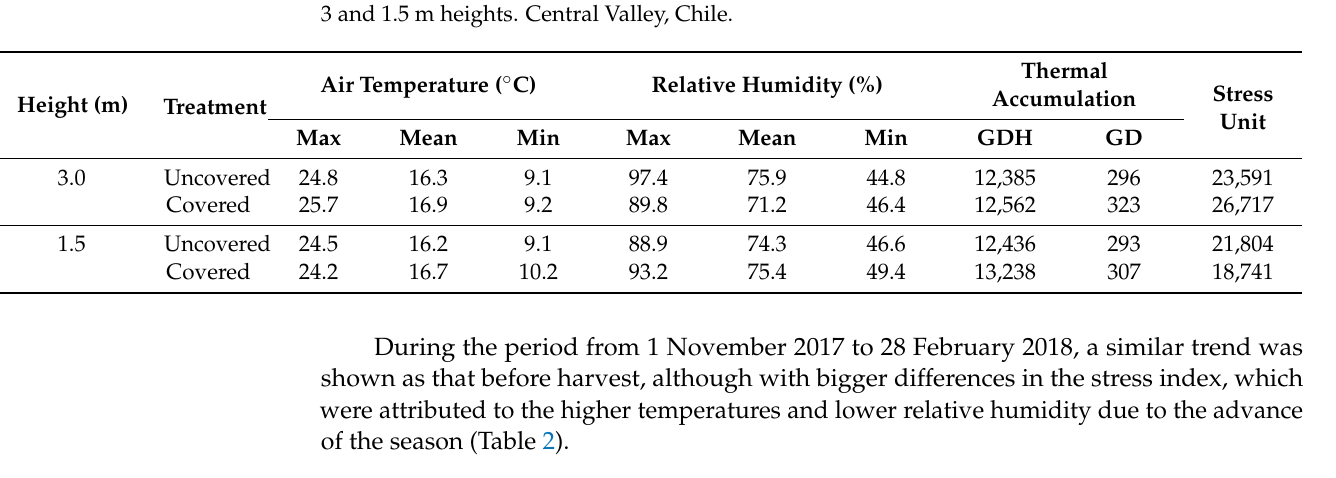
Table 2. Air temperature, relative humidity, thermal accumulation and stress index between 1 November 2017 and 28 February 2018 in sweet cherry trees with and without rain cover at 3 and 1.5 m heights. Central Valley, Chile.